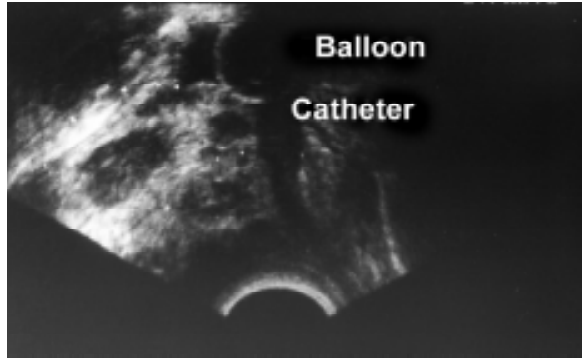
Figure 3 – Prostatic abdominal ultrasonography showing the prostatic